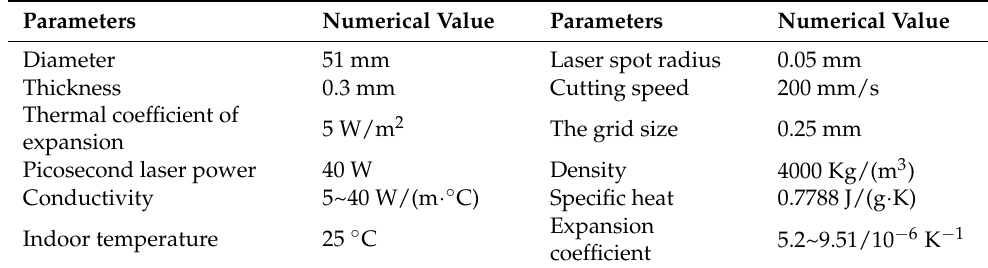
Table 2. Numerical simulation parameters.